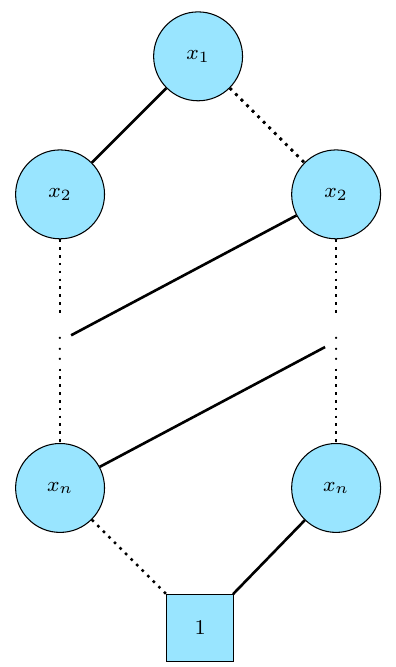
Figure 6. A translation using the extended XOR primitive.